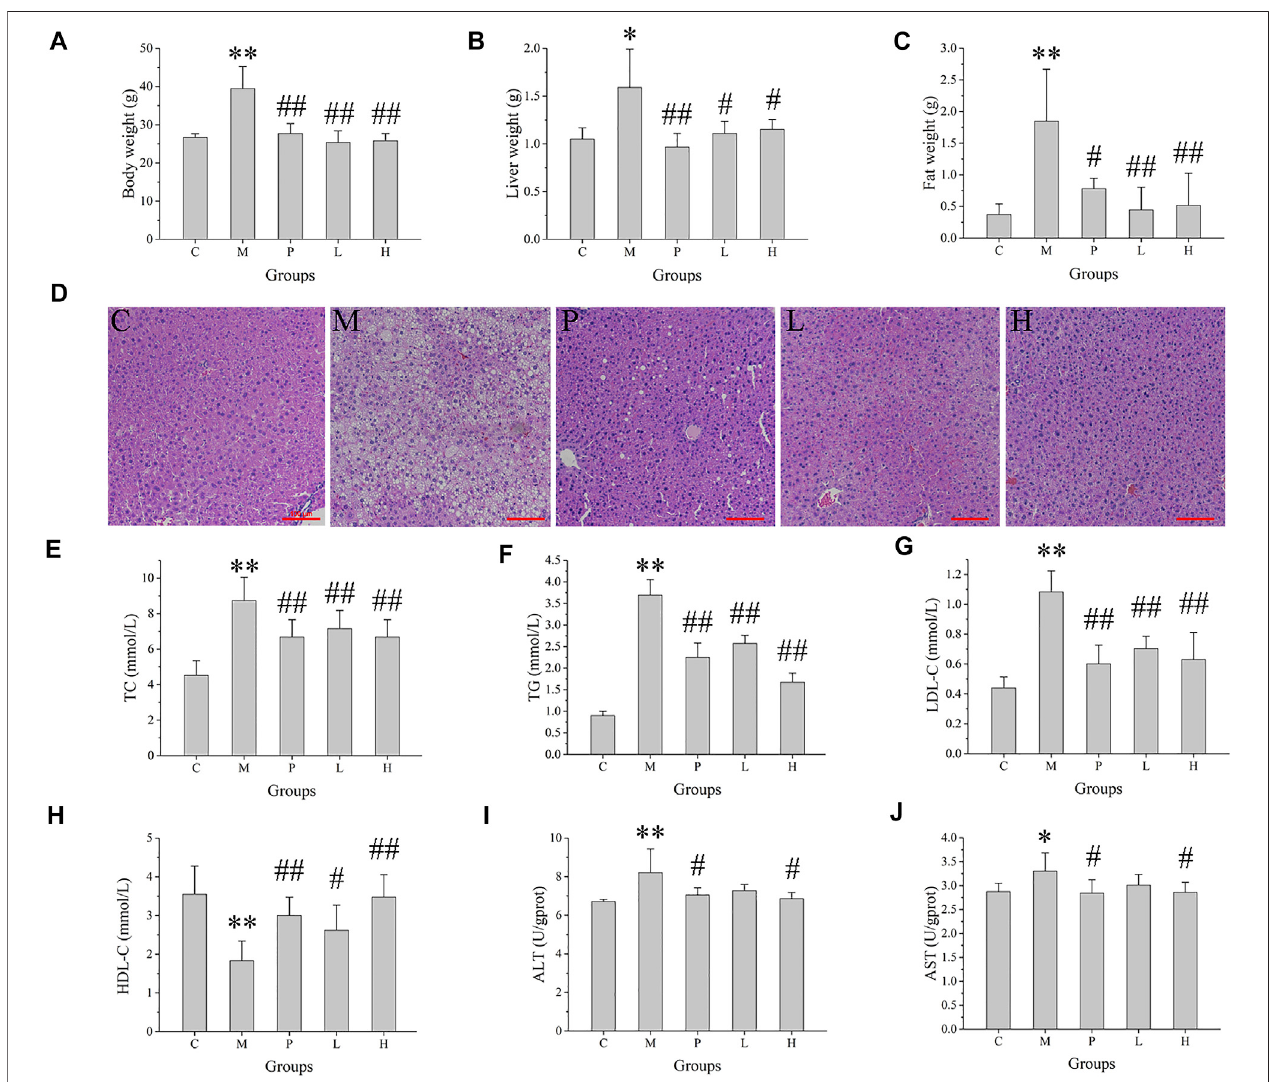
FIGURE 1 | Effects of baicalein treatment on the liver and lipid metabolism. (A) Body weight. (B) Liver weight. (C) Epididymal fat weight. (D) Histopathological analysis of liver. (E) Serum total cholesterol (TC). (F) Serum total triglyceride (TG). (G) Serum low density lipoprotein-cholesterol (LDL-C). (H) Serum high density lipoprotein-cholesterol(HDL-C). (I) Serumalanineaminotransferase(ALT)activity. (J) Serumaspartateaminotransferase(AST)activity.Dataarepresentedasmean±SD ( n = 10). ** p < 0.01, * p < 0.05, compared with the C group; ## p < 0.01, # p < 0.05, compared with the M group.